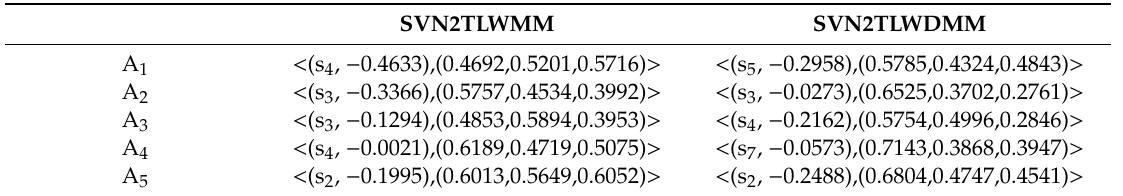
Table 2. The aggregating results of the green suppliers by the single-valued neutrosophic 2-tuple linguistic dual Muirhead mean (SVN2TLWMM) (single-valued neutrosophic 2-tuple linguistic weighted dual Muirhead mean (SVN2TLWDMM)) operator.